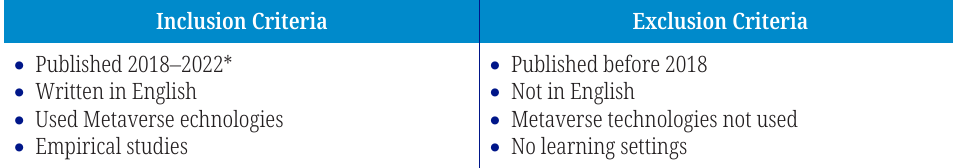
Table 1. Inclusion and exclusion